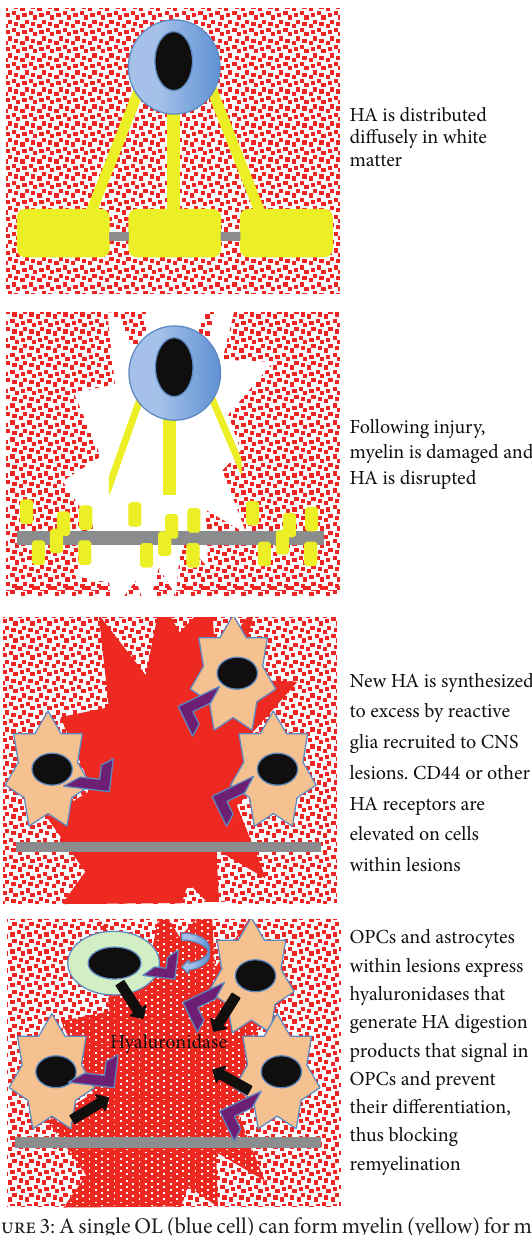
Figure 3: A single OL (blue cell) can form myelin (yellow) for multi- ple internodes of the same axon (gray) or for many axons. In unin- juredwhitematter,HA(red)isdiffusewhileinperineuronalnetsHA is at much higher density (not shown). Following injury, myelin and oligodendrocytes are destroyed and HA is initially disrupted. HA later accumulates at higher than normal levels coincident with the appearance of reactive astrocytes (orange cells). CD44 and possibly other HA receptors (purple) are elevated on astrocytes and OPCs recruited to lesions. Both astrocytes and recruited OPCs (green cell) then express hyaluronidases (including PH20; black arrows in lower panel) that digest the excess HA within lesions. The resulting HA digestion products that accumulate in the injury microenvironment feed back on OPCs (blue arrow in lower panel) and prevent their differentiation and subsequent